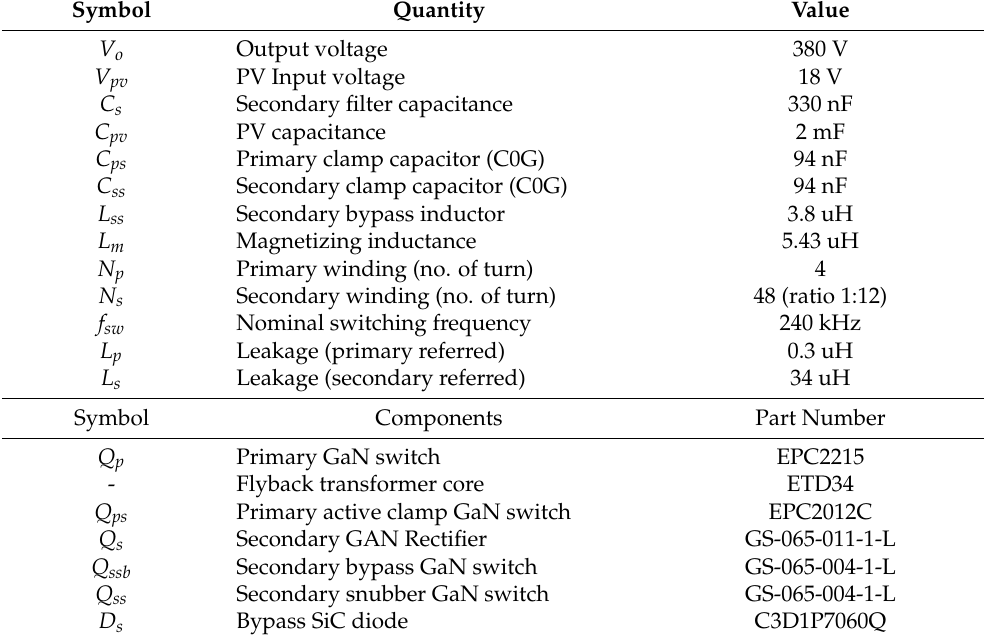
Table 2. Experimental